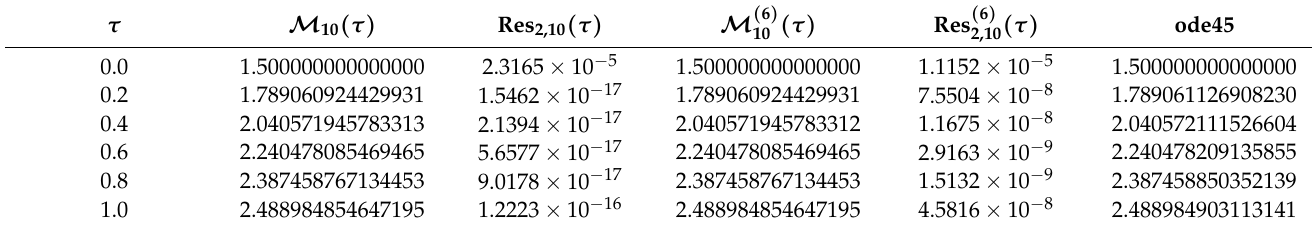
Table 5. The comparison of numerical results for in Test Case